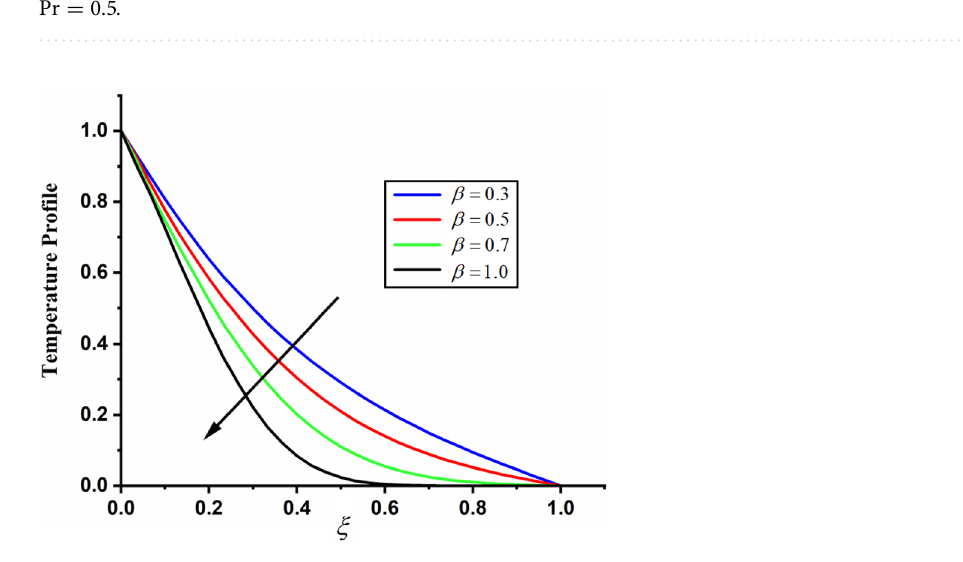
Figure 13. The impact of β on the temperature of couple stress fluid when, α = 0.5 , Re = 3.2 , t = 0.2 and Pr = 0.5